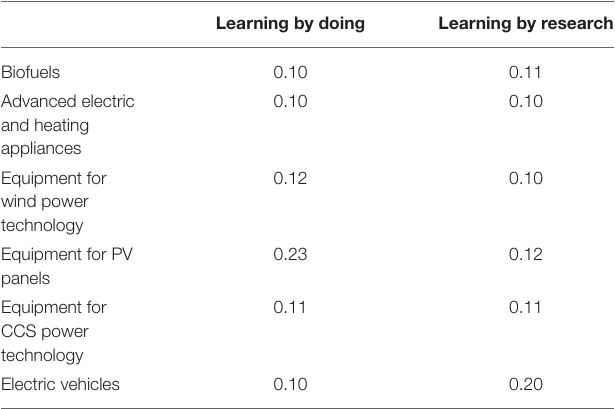
TABLE 1 | Learning by doing and R&D rates used in GEM-E3-FIT. Learning by